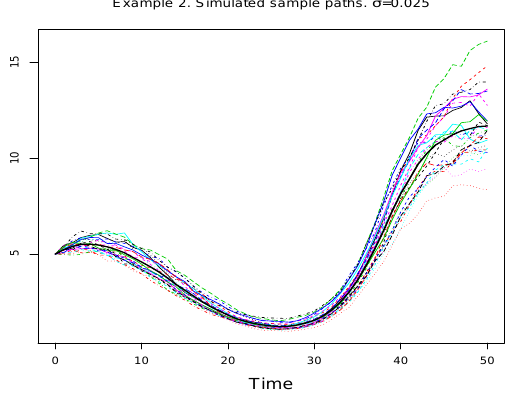
Figure 6. Example 2. Simulated sample-paths. The black line represents the sample mean.